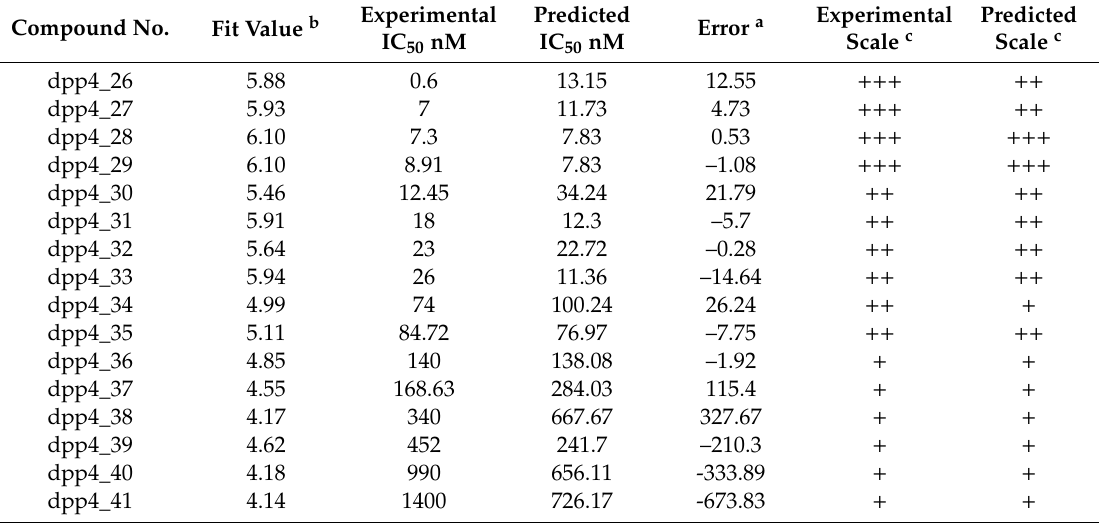
Table 2. The experimental dipeptidyl peptidase-IV inhibitory activities and predicted activities obtained by HypoGen program on the basis of the pharmacophore model Hypo1 (test set). Compound